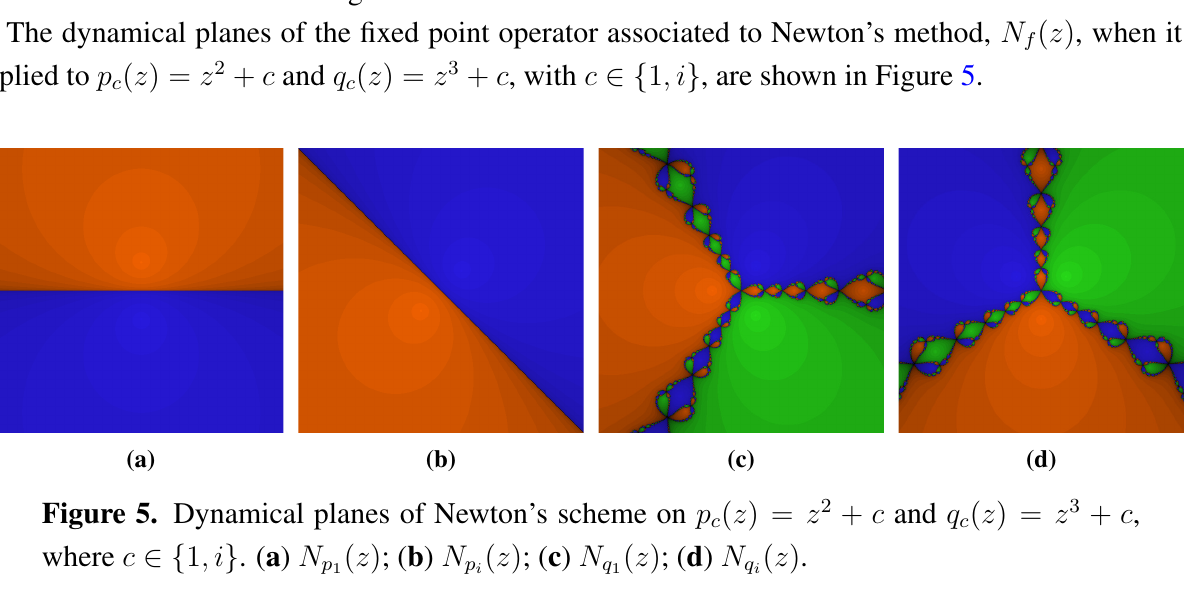
Figure 4. Dynamical planes of iterative methods on q ( z ) ; ( d ) X ( c ) E q 1